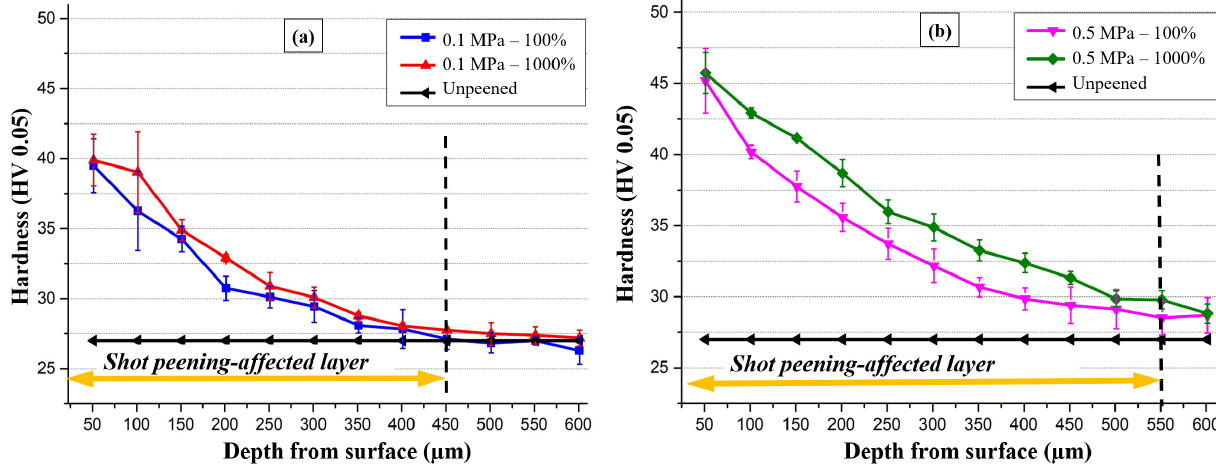
Figure 2. Change in hardness along depth under different cover rates at peening pressures of ( a ) 0.1 MPa and ( b ) 0.5 MPa.